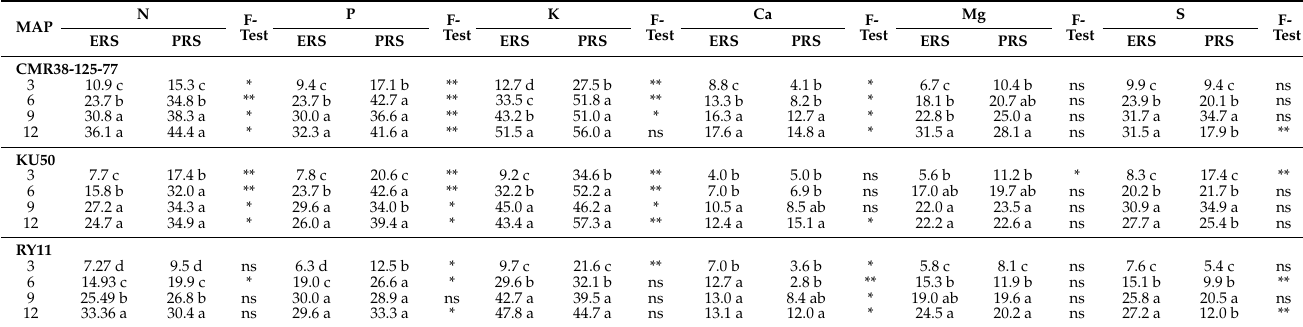
Table 4. Percent of nutrient removal from the soil by the storage roots of three cassava genotypes in the early rainy season (ERS) and post rainy season (PRS) with full